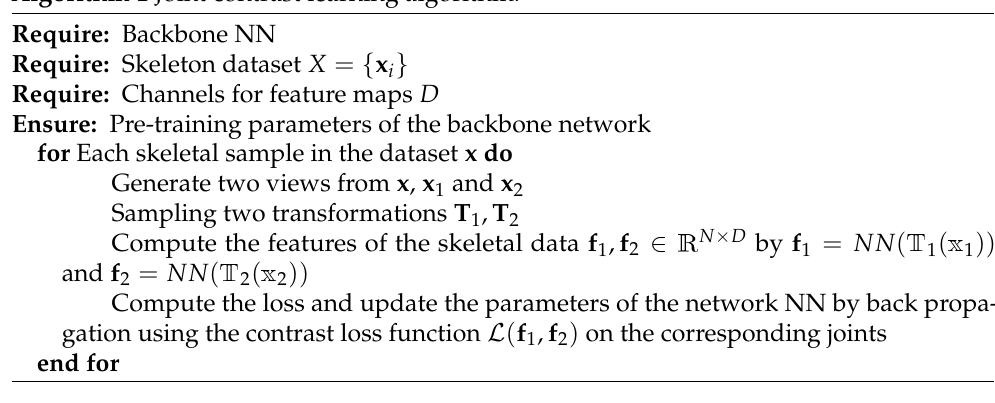
Algorithm 1 Joint contrast learning